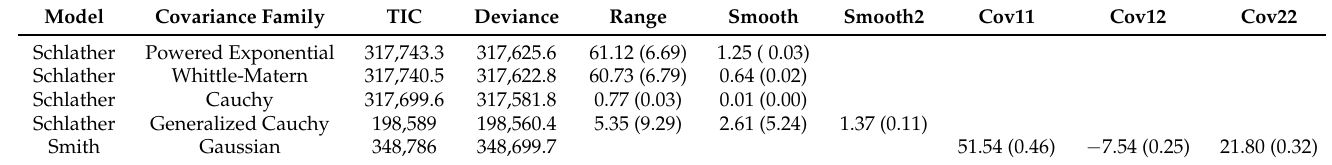
Table 6. Max-stable process fitted to the first cluster of the annual maximum temperatures.